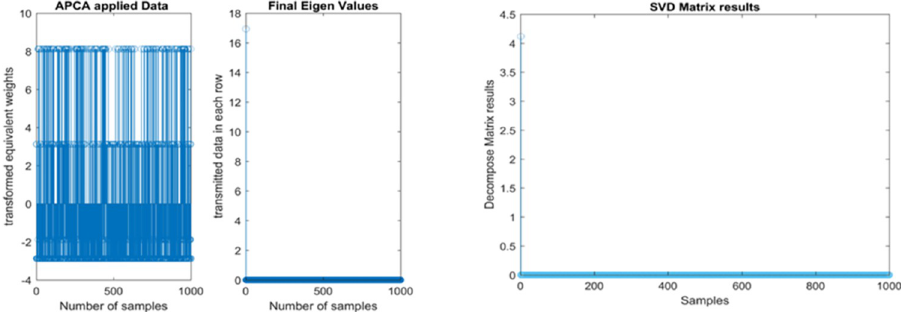
Fig 6. (a). PCA and eigen values of proposed model. (b). SVD matrix results of proposed